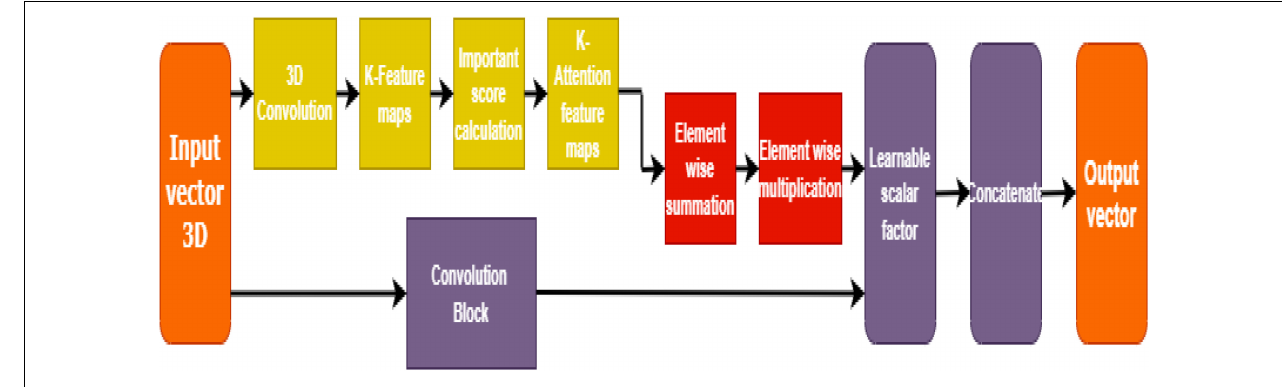
FIGURE 6 | Soft attention mechanism.